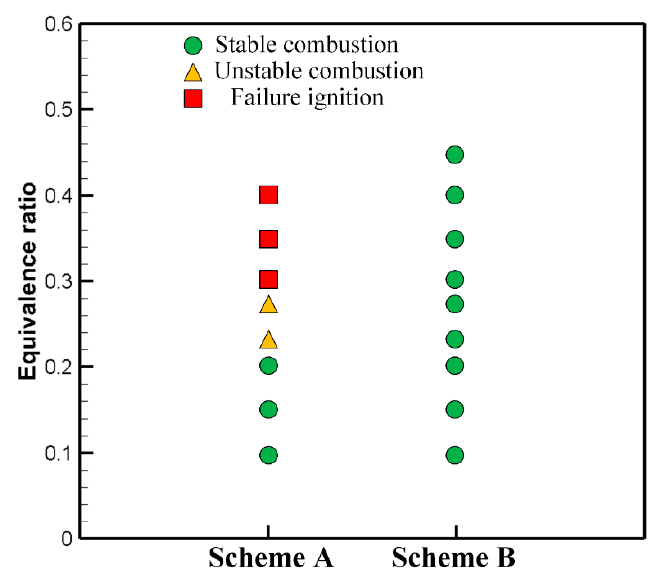
Figure 3. Schematic of the experimental states of all cases in Table 2.